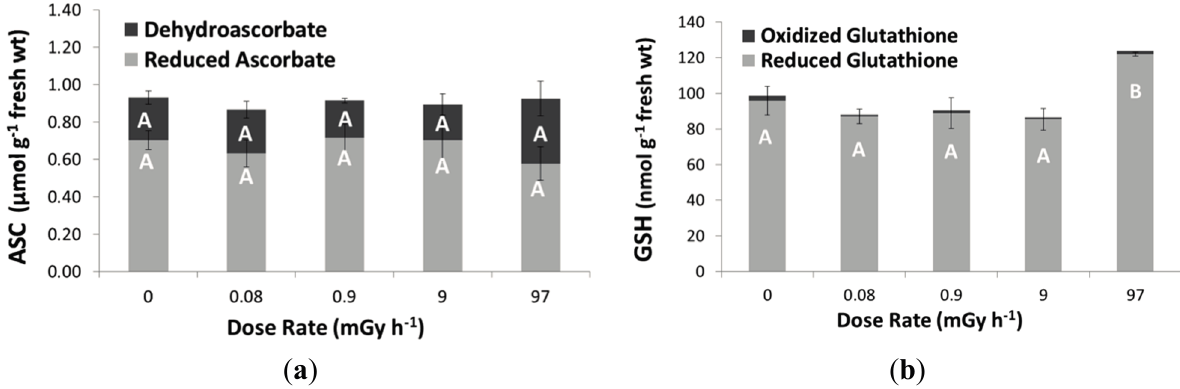
Figure 4. Metabolite concentrations of ( a ) ascorbate (ASC) and ( b ) glutathione (GSH) in L. minor exposed to different dose rates levels of β -radation for seven days. Concentration levels of reduced and oxidized forms of the metabolites are shown in light and dark grey bars, respectively. Each data point represents the mean ± SE of three biological